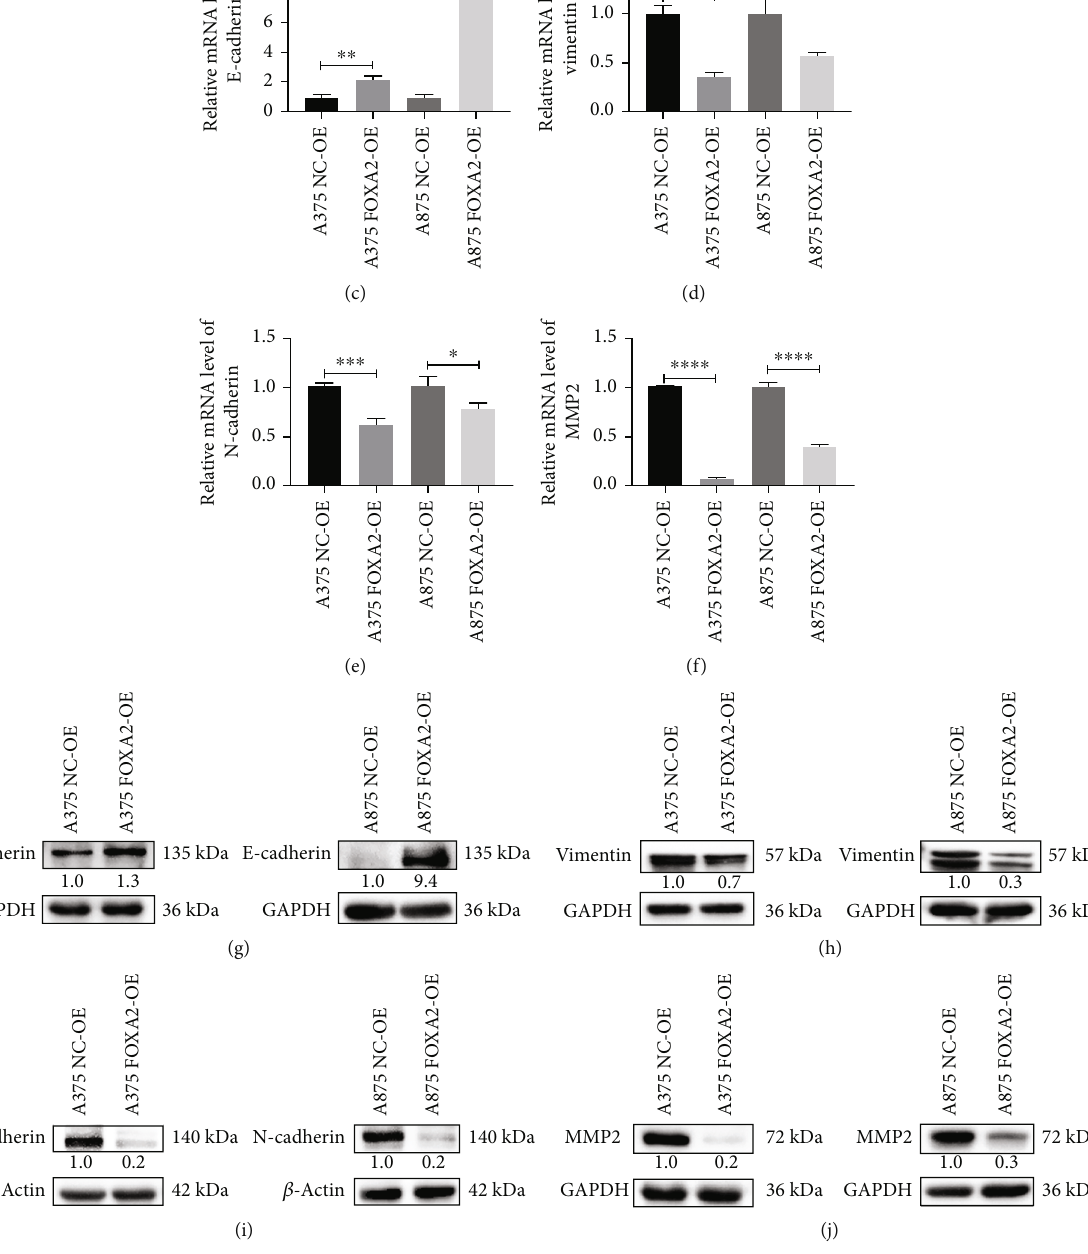
Figure 9: FOXA2 inhibits melanoma cell migration and invasion in vitro . (a, b) Analysis of the e ff ect of FOXA2 on melanoma cell migration and invasion using Transwell assays. Quantitative results are shown below the images. (c – f) RT-qPCR analysis of the relative mRNA expression of E-cadherin, vimentin, N-cadherin, and MMP2 in NC-OE and FOXA2-OE melanoma cells. (g – j) Western blotting analysis of the protein expression of E-cadherin, vimentin, N-cadherin, and MMP2 in NC-OE and FOXA2-OE melanoma cells. Scale bars = 100 μ m. ∗ p < 0 : 05 , ∗∗ p < 0 : 01 , ∗∗∗ p < 0 : 001 , and ∗∗∗∗ p < 0 : 0001 vs. control